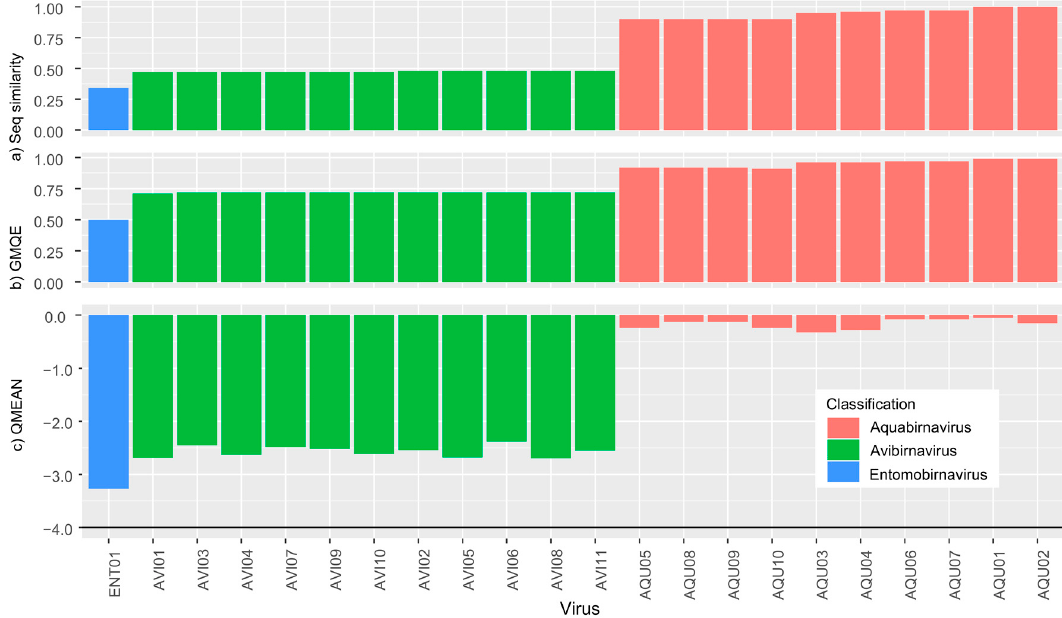
Figure 4. Swiss Model results for ( a ) sequence similarity, ( b ) Global Model Quality Estimate (GMQE) and ( c ) QMEAN for sequences from Birnaviridae. Higher QMEAN scores indicate a better match to the template and the horizontal line in the QMEAN graph at − 4 indicates the model quality cut off point.